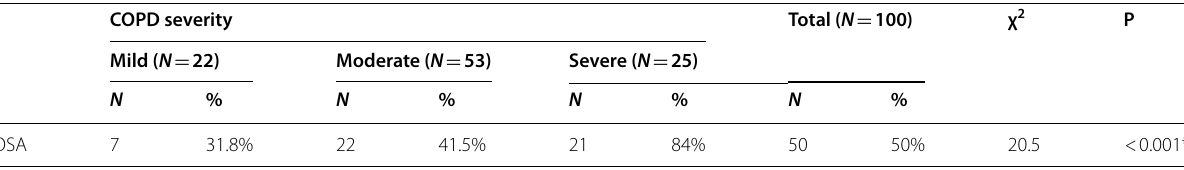
COPD chronic obstructive pulmonary diseases, OSA obstructive sleep apnea